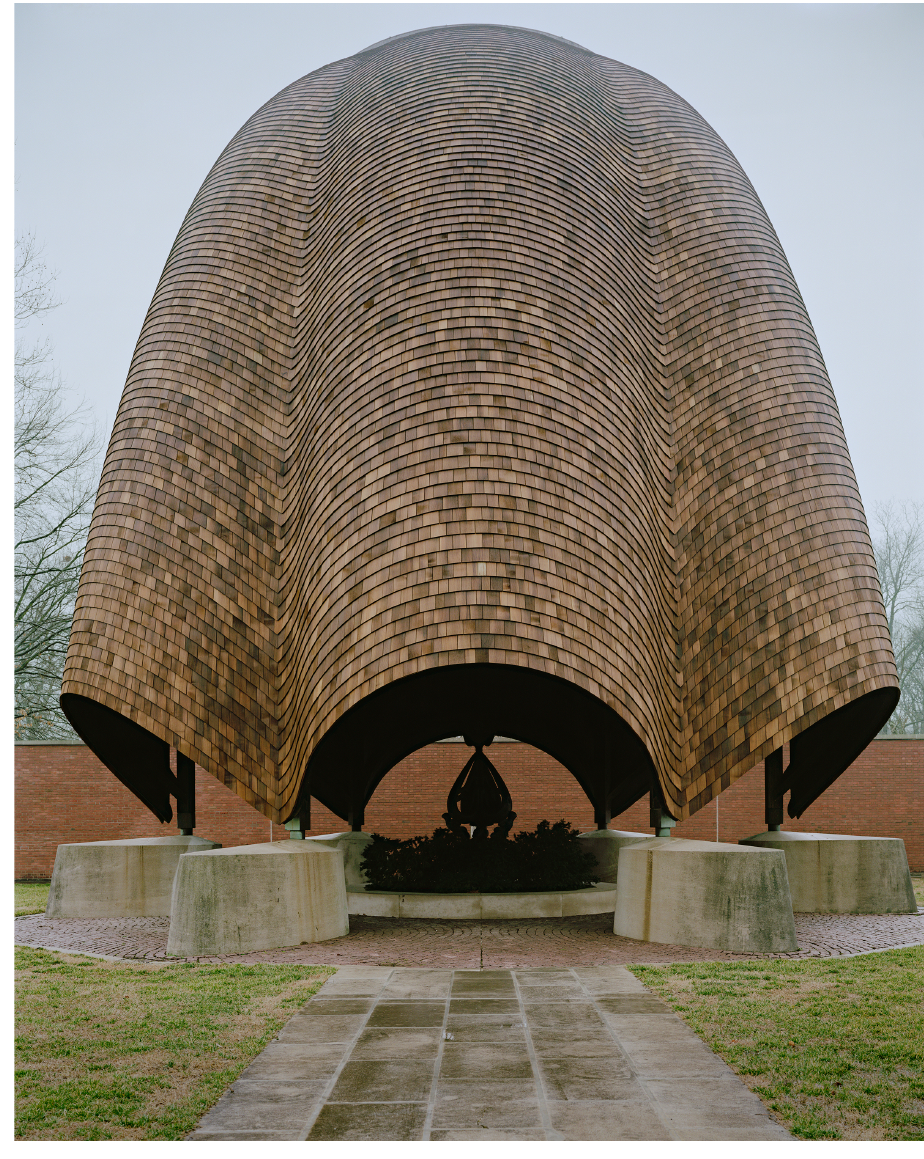
the earth and sky, blurring both into an indistinct zone of ethereality, recalling theophany’s recurring theme of “God in the mist” dematerializing the world. When the mist dissolves, hard edges and straight lines reinforce the communities’ asceticism. Ascetic Living (2012, Digital C-Print) is broken into clean horizontals: the grass, the road, the lawn, a two-story house, a bank of trees and blue sky. The white building is window blind. The lawn is freshly mowed. The road hints at travelers, passersby, the curious or indifferent. But the building holds the center, inward-turning, defensive, the purity of its windowless white confrontational. The vertical slash of a shadowed door is a riddle of non-invitation,